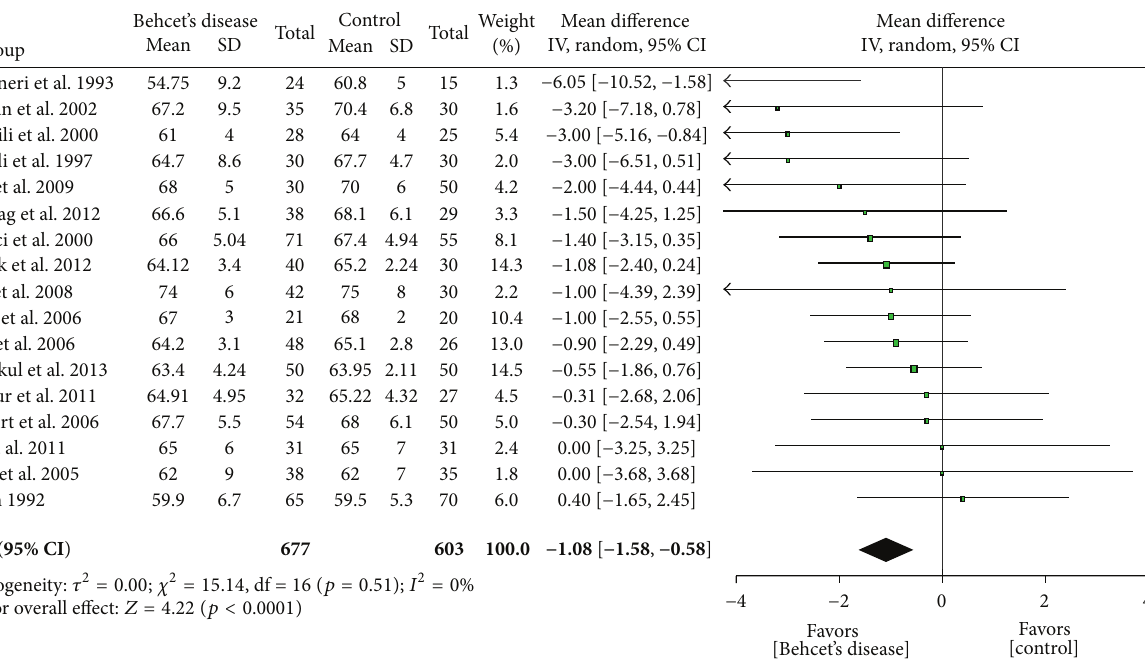
Figure 4: Left ventricular ejection fraction comparison between patients with Behcet’s disease and